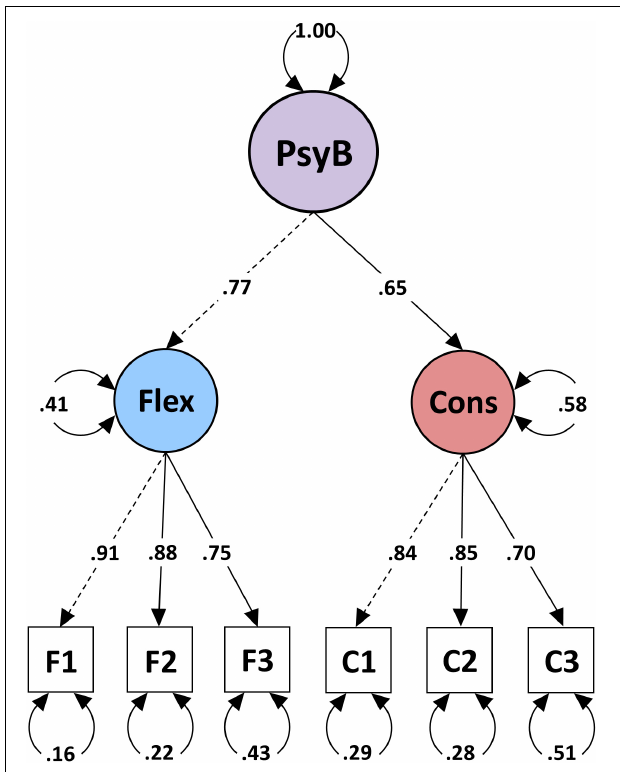
FIGURE 4 | Study 2: High-order structure of Psychological Balance.